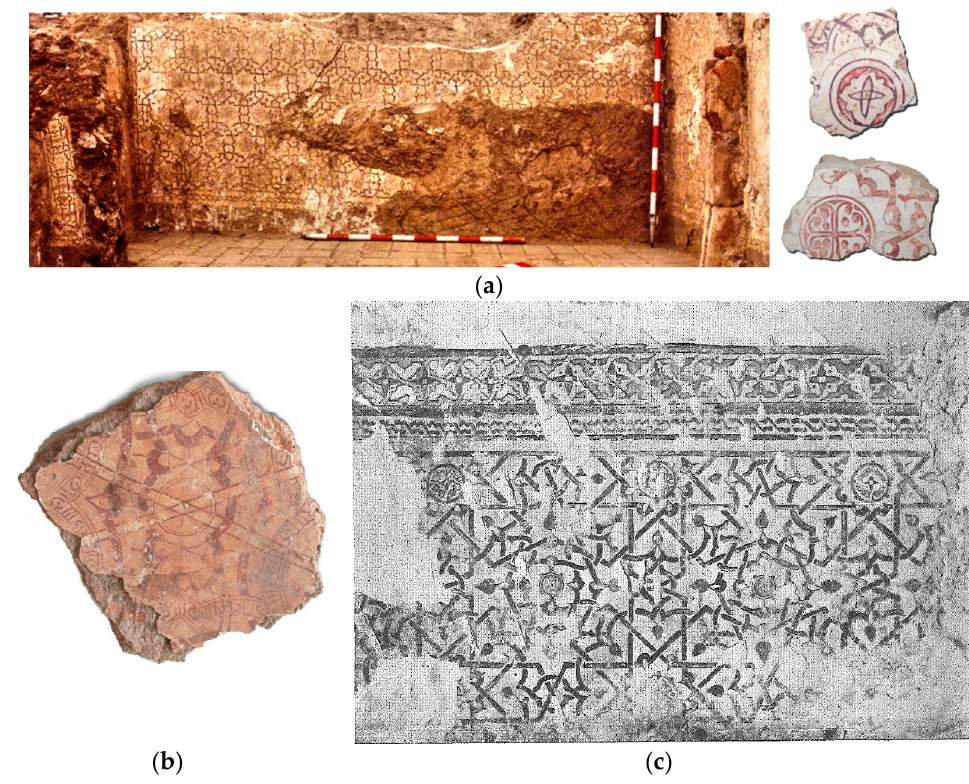
Figure 12. Late Islamic paintings in al-Andalus: ( a ) Huerta Rufino, Ceuta, late 13th–early 14th century (Villada and Hita 2017, p. 254–55); ( b ) D ā r al- ῾ Ar ū sa Palace, Granada, middle of the 14 th century (Patronato de la Alhambra 2018); ( c ) Sala de la Barca, Alhambra, Granada, 14th century (Torres Balbás 1942, p. 130).